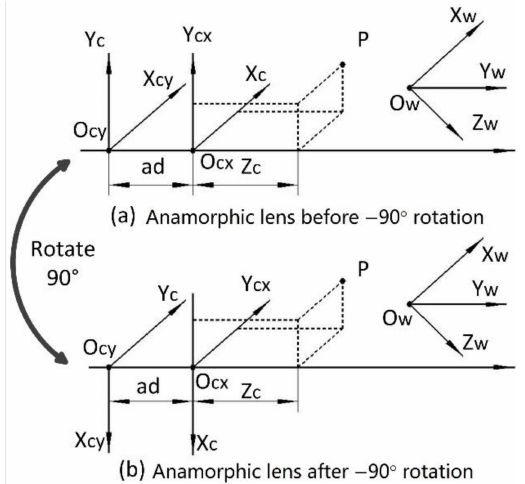
Figure 2. The two anamorphic positions. ( a ) Vertical position and ( b ) horizontal position which is achieved by a rotation of the anamorphic lens in the vertical position by − 90 ◦